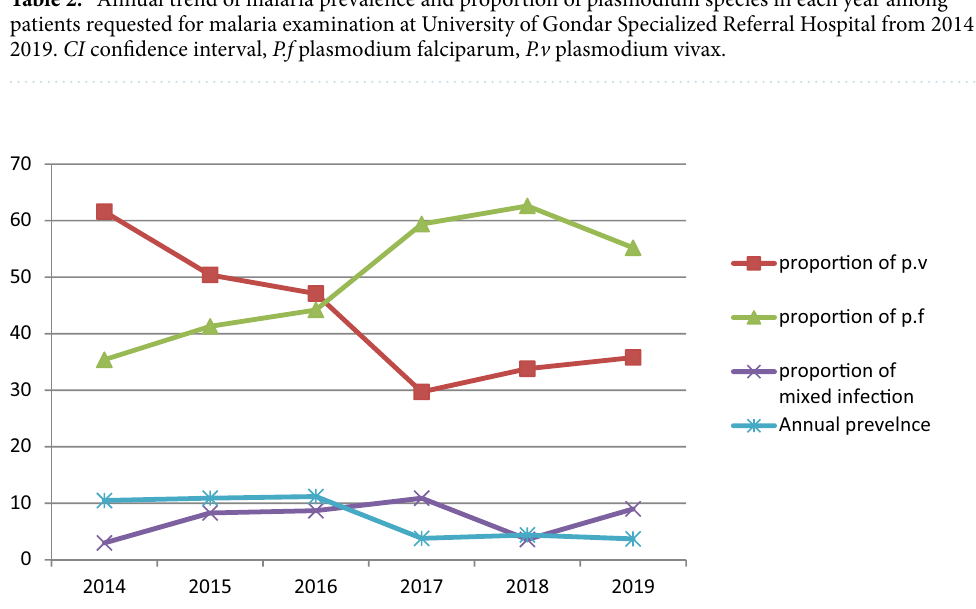
Figure 1. Annual trend of malaria prevalence and proportion of plasmodium species at University of Gondar specialized referral hospital from 2014 to